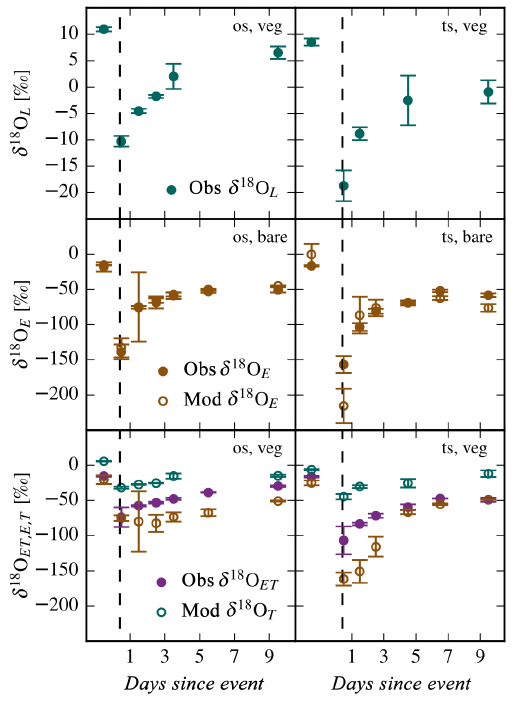
Figure 4. Mean daily isotopic composition of bulk leaf water δ 18 O L , soil evaporation δ 18 O E , plant transpiration δ 18 O T and combined evapotranspiration δ 18 O ET from bare-soil (bare) or vege- tation plots (veg) at open sites between tree crowns (os) and shaded sites beneath tree crowns (ts). Filled dots represent observed values (obs); hollow dots represent modelled values (mod). Dashed lines mark time of watering event. Uncertainty bars display standard er- ror.